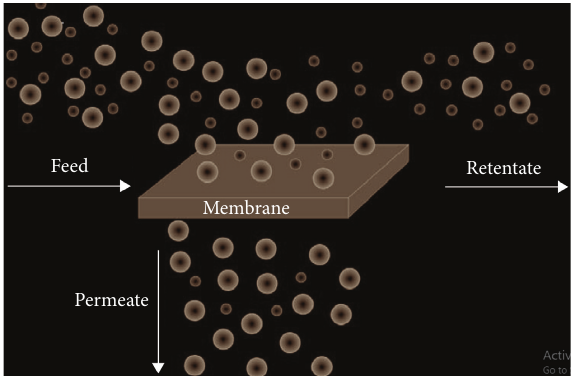
Figure 2: Membrane for gas stream